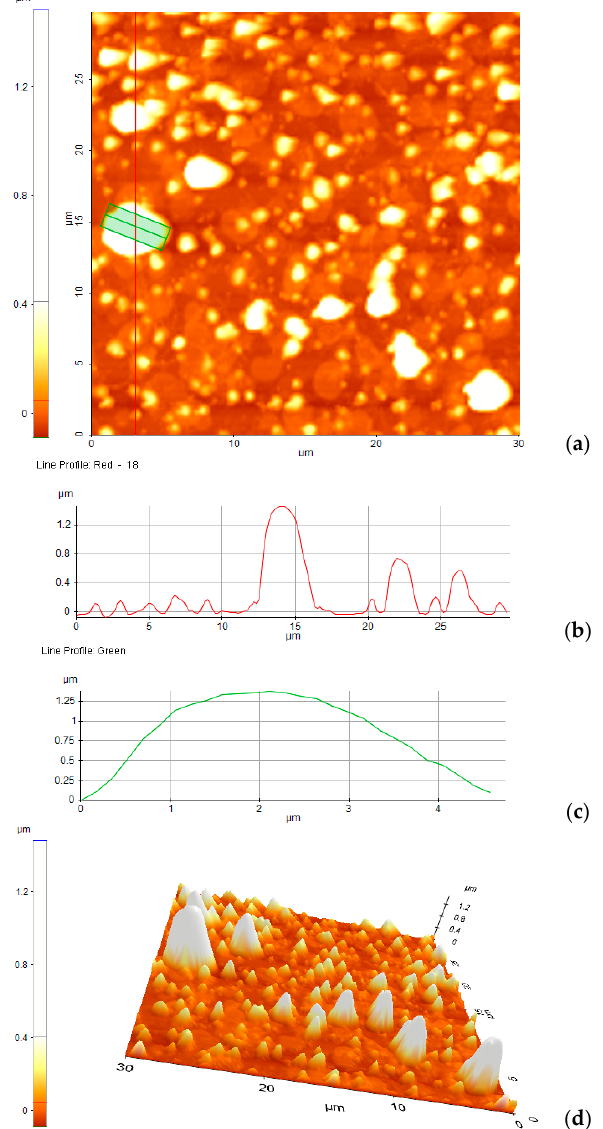
Figure 12. ( a ) The 2D topography of the surface on which BPA was deposited (30 × 30 μ m); BPA deposition surface line profiles: ( b ) red and ( c ) green; ( d ) the 3D surface topography of the glass plate coated with BPA.